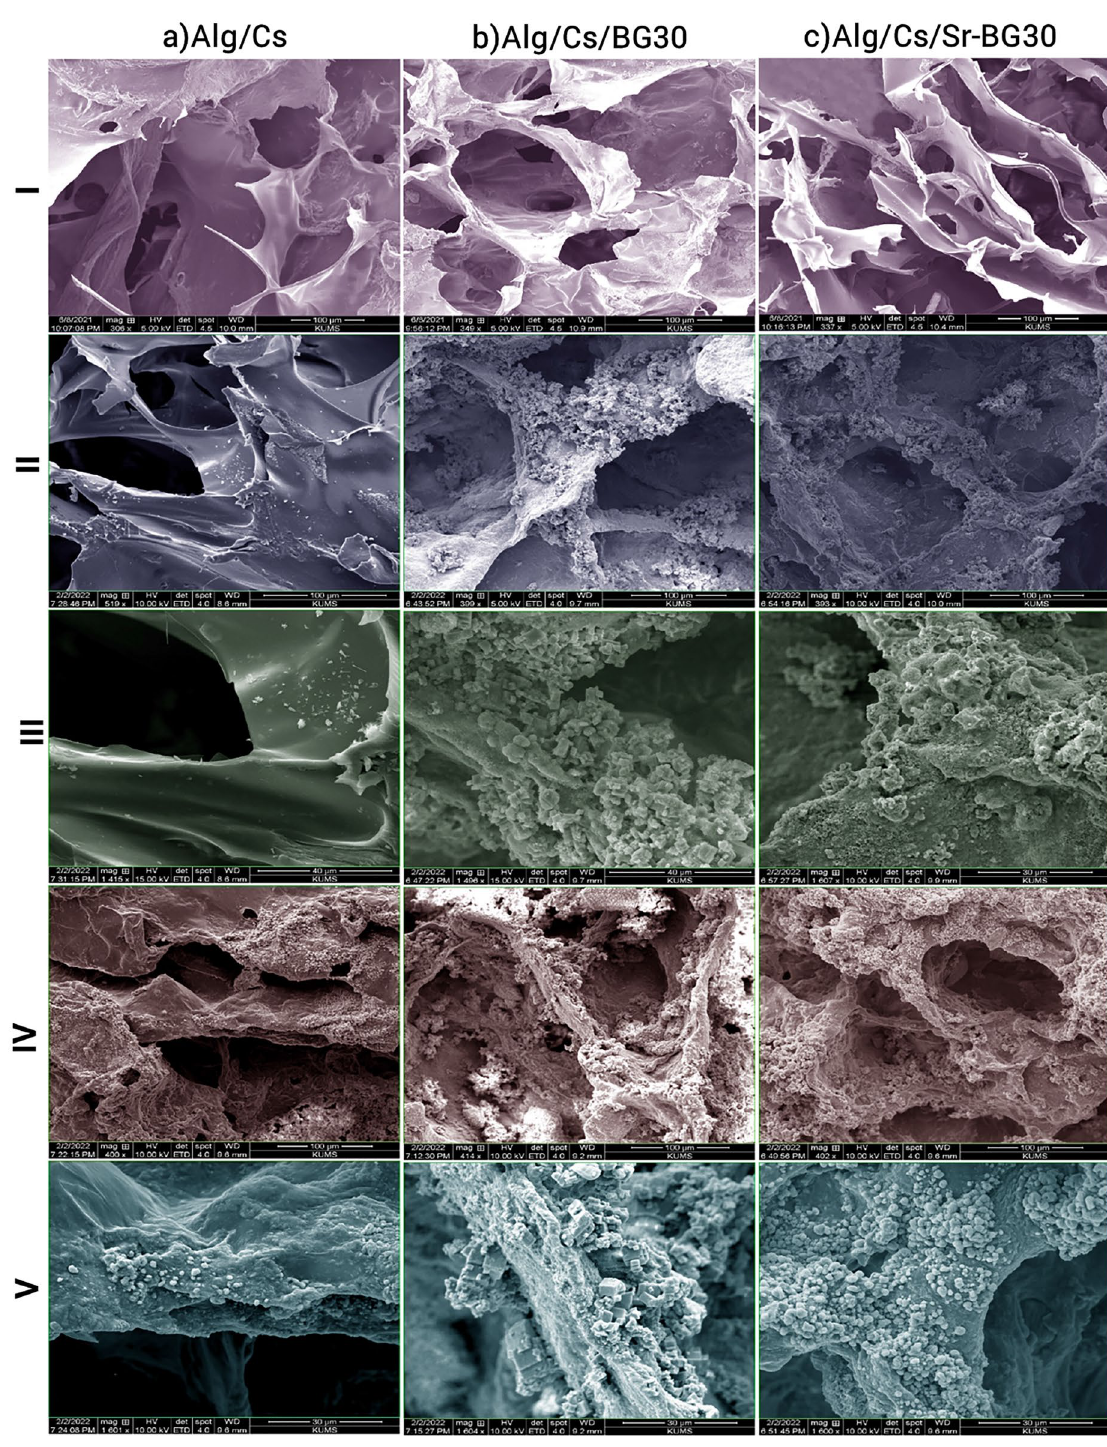
Figure 5. SEM images of scaffolds surface for evaluating biomineralization. ( a ) Alg/Cs, ( b ) Alg/Cs/BG30 and ( c ) Alg/Cs/Sr-BG30 scaffolds, (I) before submerging, (II) after 7 days submerging (100 μm scale), (III)